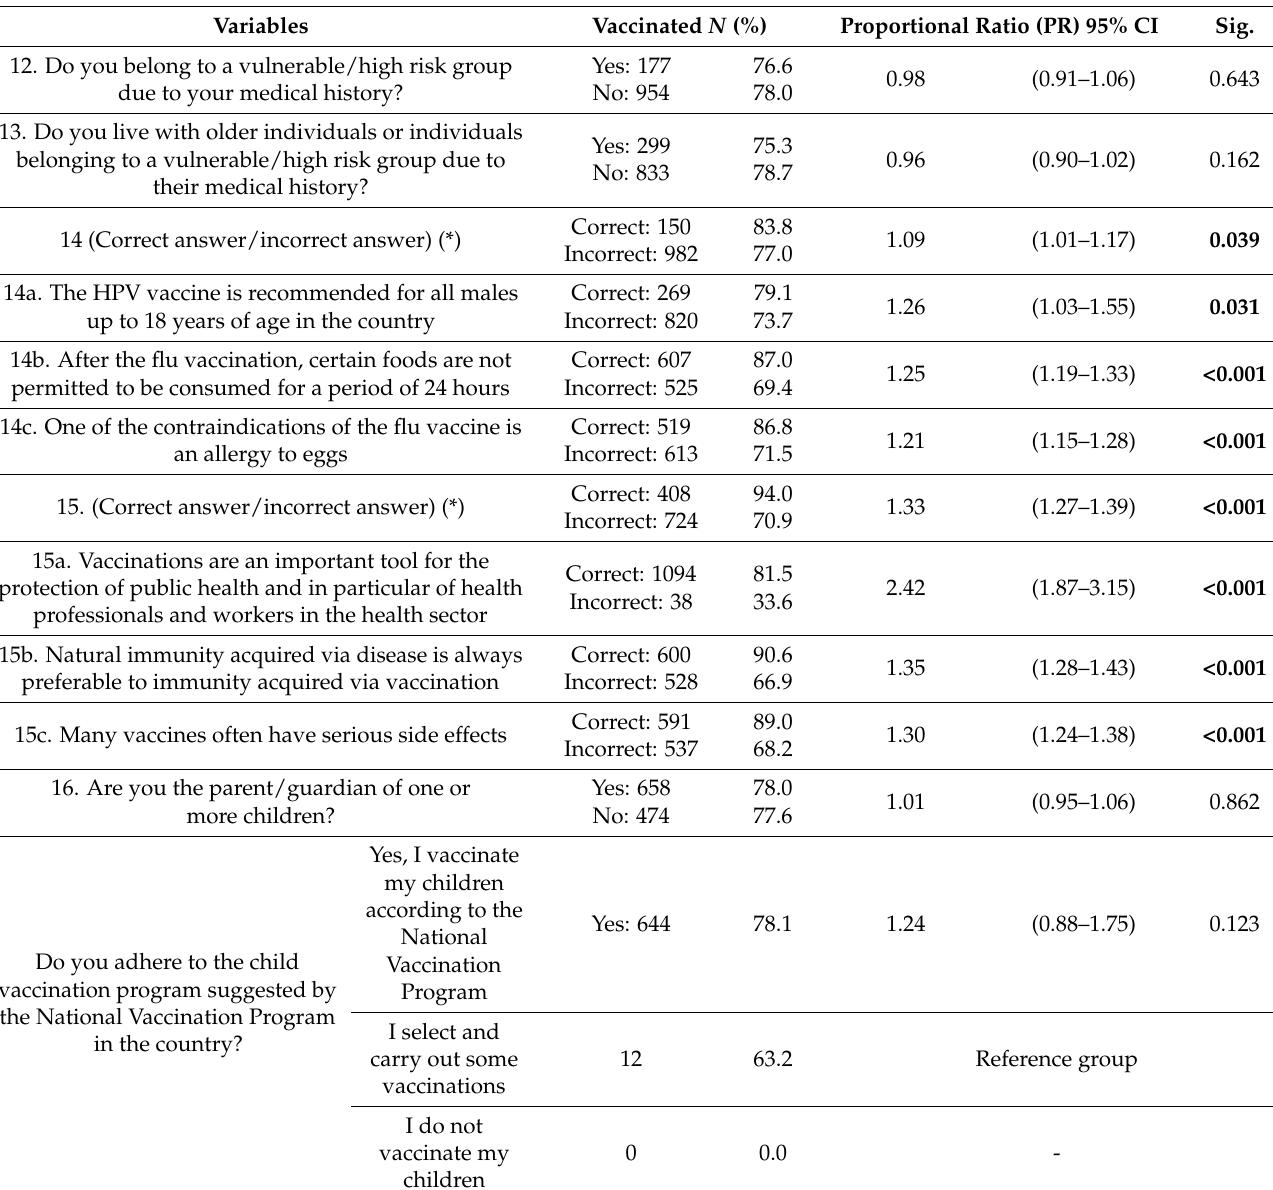
Table 3. Section A questions “participants’ knowledge about vaccines and their attitude to vaccination” associated with COVID-19 vaccine acceptance, expressed with proportional ratio in univariate